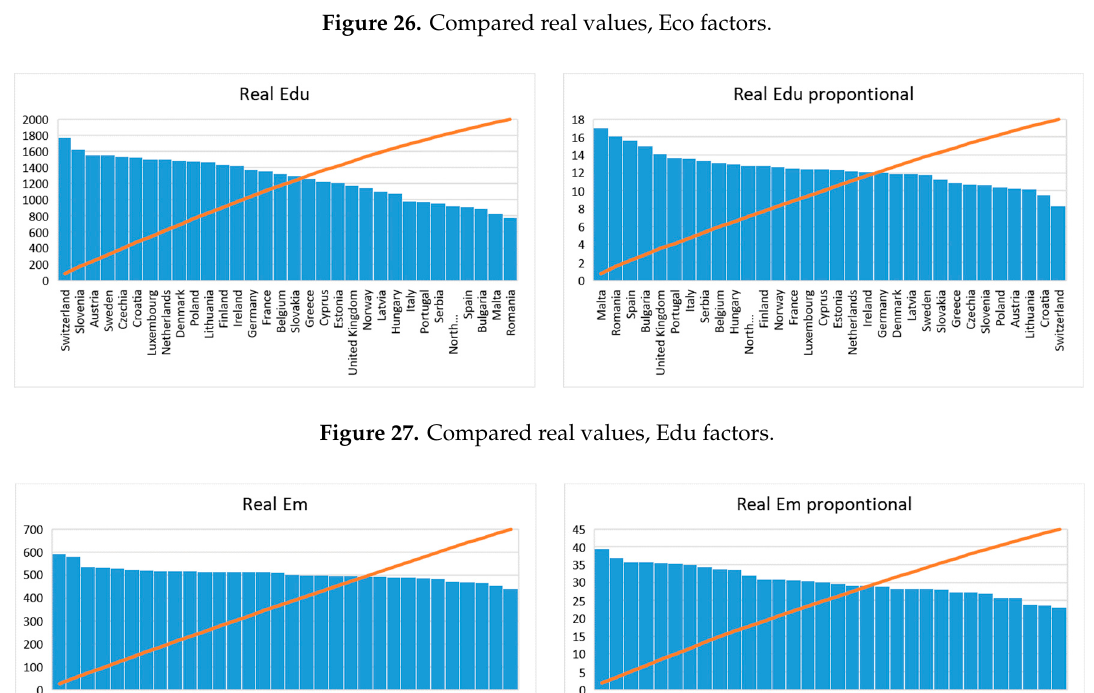
Figure 28. Compared real values, EM factors.